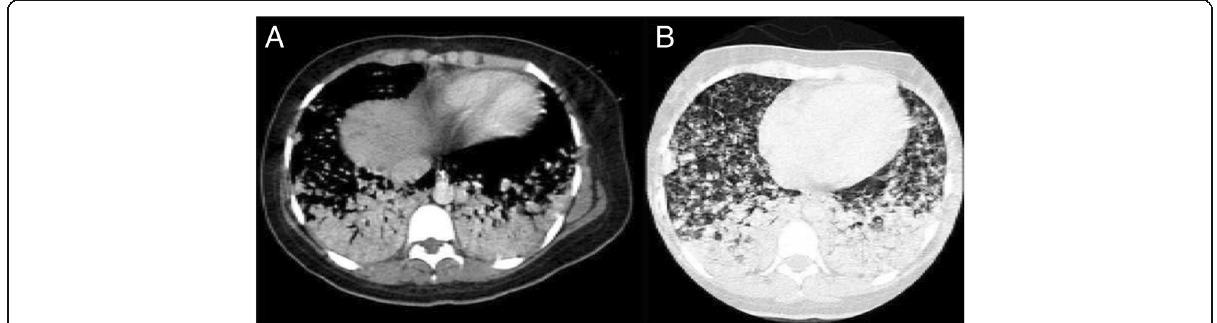
Fig. 6 Axial computed tomography scans of the thorax in the mediastinal and lung window demonstrating consolidations ( a ), suggestive of confluence of the secondary lesions or inflammatory/infectious process ( b )